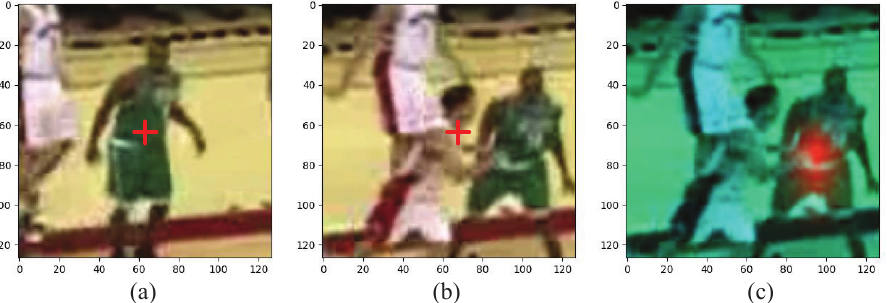
Figure 3. Visualization of the cosine similarity. ( a ) is the original template image, ( b ) is the image cropped by the tracking result in the subsequent, and ( c ) is the cosine similarity added into the image patch. The red region represents the high